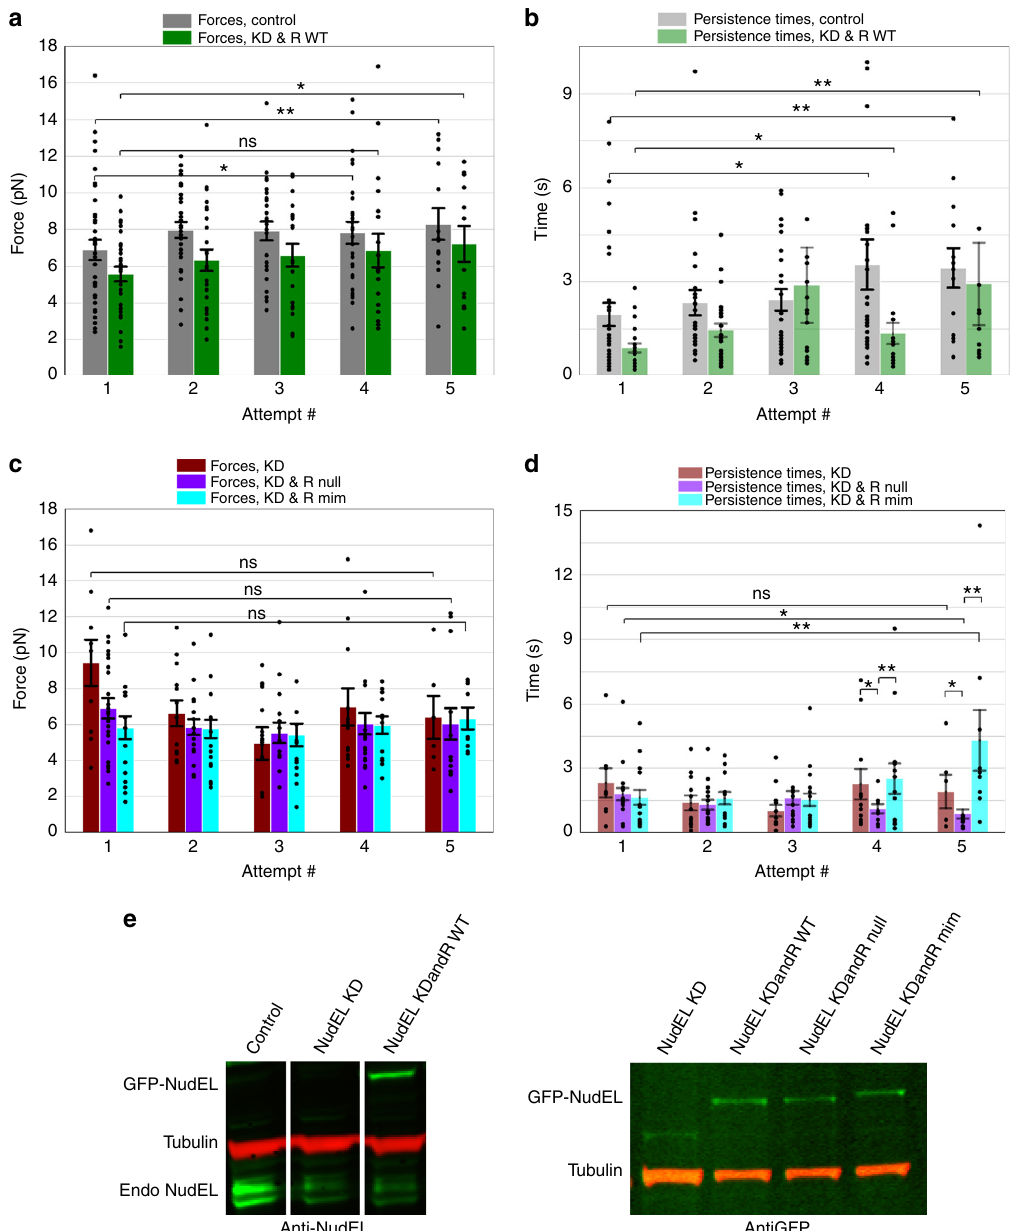
Fig. 6 NudEL knockdown and replacement force pro fi les depends on NudEL phospho-state. Average minus-end peak forces ( a ) and persistence times ( b ) for control and NudEL knockdown and NudEL-WT replacement backgrounds. Average minus-end peak forces ( c ) and persistence times ( d ) for NudEL knockdown and NudEL knockdown and phospho-null and phospho-mimetic replacement backgrounds. Average endogenous NudEL/NudE (Endo NudEL/ NudE) knockdown was 70%; average exogenous replacement (GFP-NudEL, band seen in NudEL KDandR WT lane) was 102% wild-type NudEL levels (left). WB probed for GFP found replacement with WT, null, and mimetic mutants resulted in similar expression levels (right). e Quanti fi ed data represent the mean ± s.e.m. of n ≥ 3 independent experiments. Two-sided t test P values * P < 0.05, ** P <